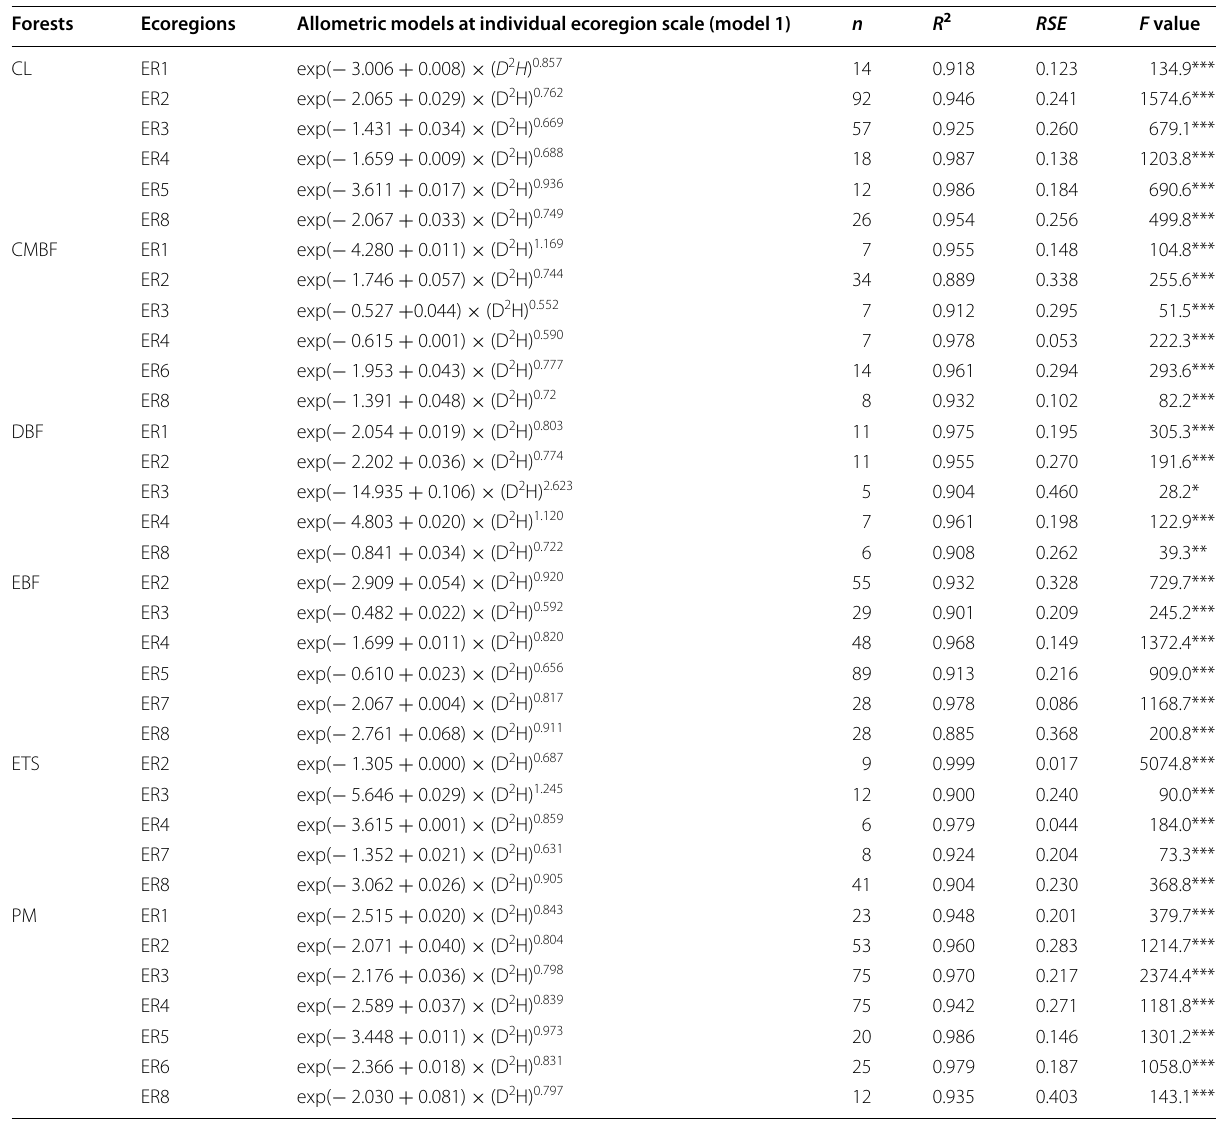
*** Indicates significant at p < 0.001 level; ** indicates significant at p < 0.01 level, * indicates significant at p < 0.05 level. See Table 1 for the abbreviations of the forest types and ecoregions